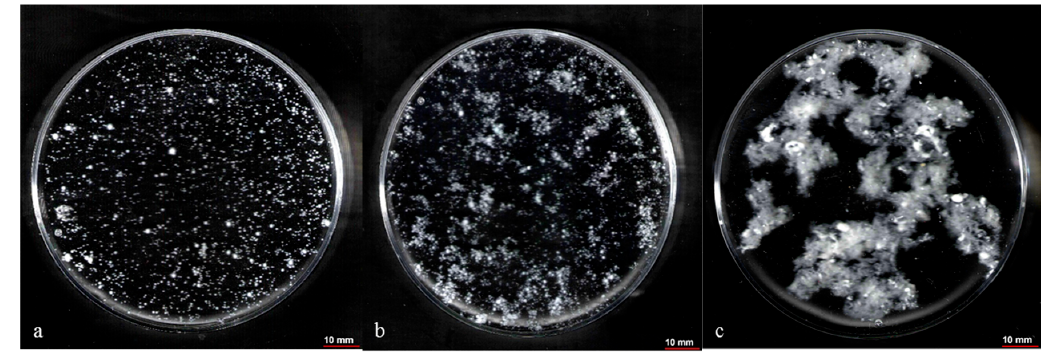
Figure 9. Images of ( a ) pelletized biomass, ( b ) dispersed mycelia using commercial nitrogen sources, and ( c ) dispersed mycelia using 200 mg/L FAN of soybean cake hydrolysate as nitrogen sources. Images were taken at 48 h of submerged fermentation of R. arrhizus NRRL 2582 using 25 g/L of initial glucose and 0.2 g/L initial ammonium sulphate concentration.